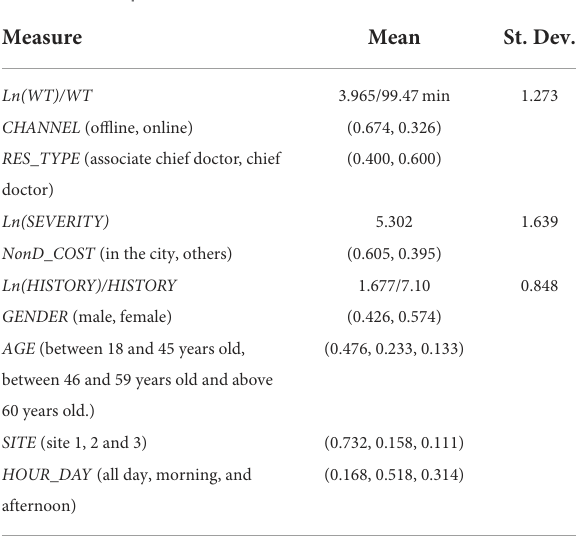
TABLE 3 Descriptive statistics for variables ( n =